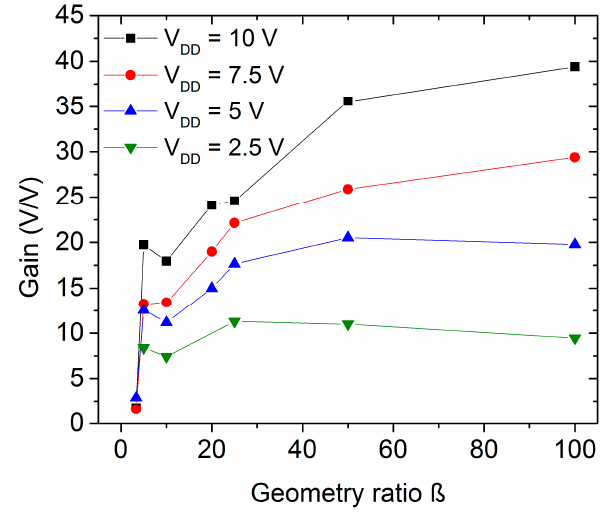
Figure 9. Average gain of the ZnO nanoparticles inverters in dependence on the geometry ratio.